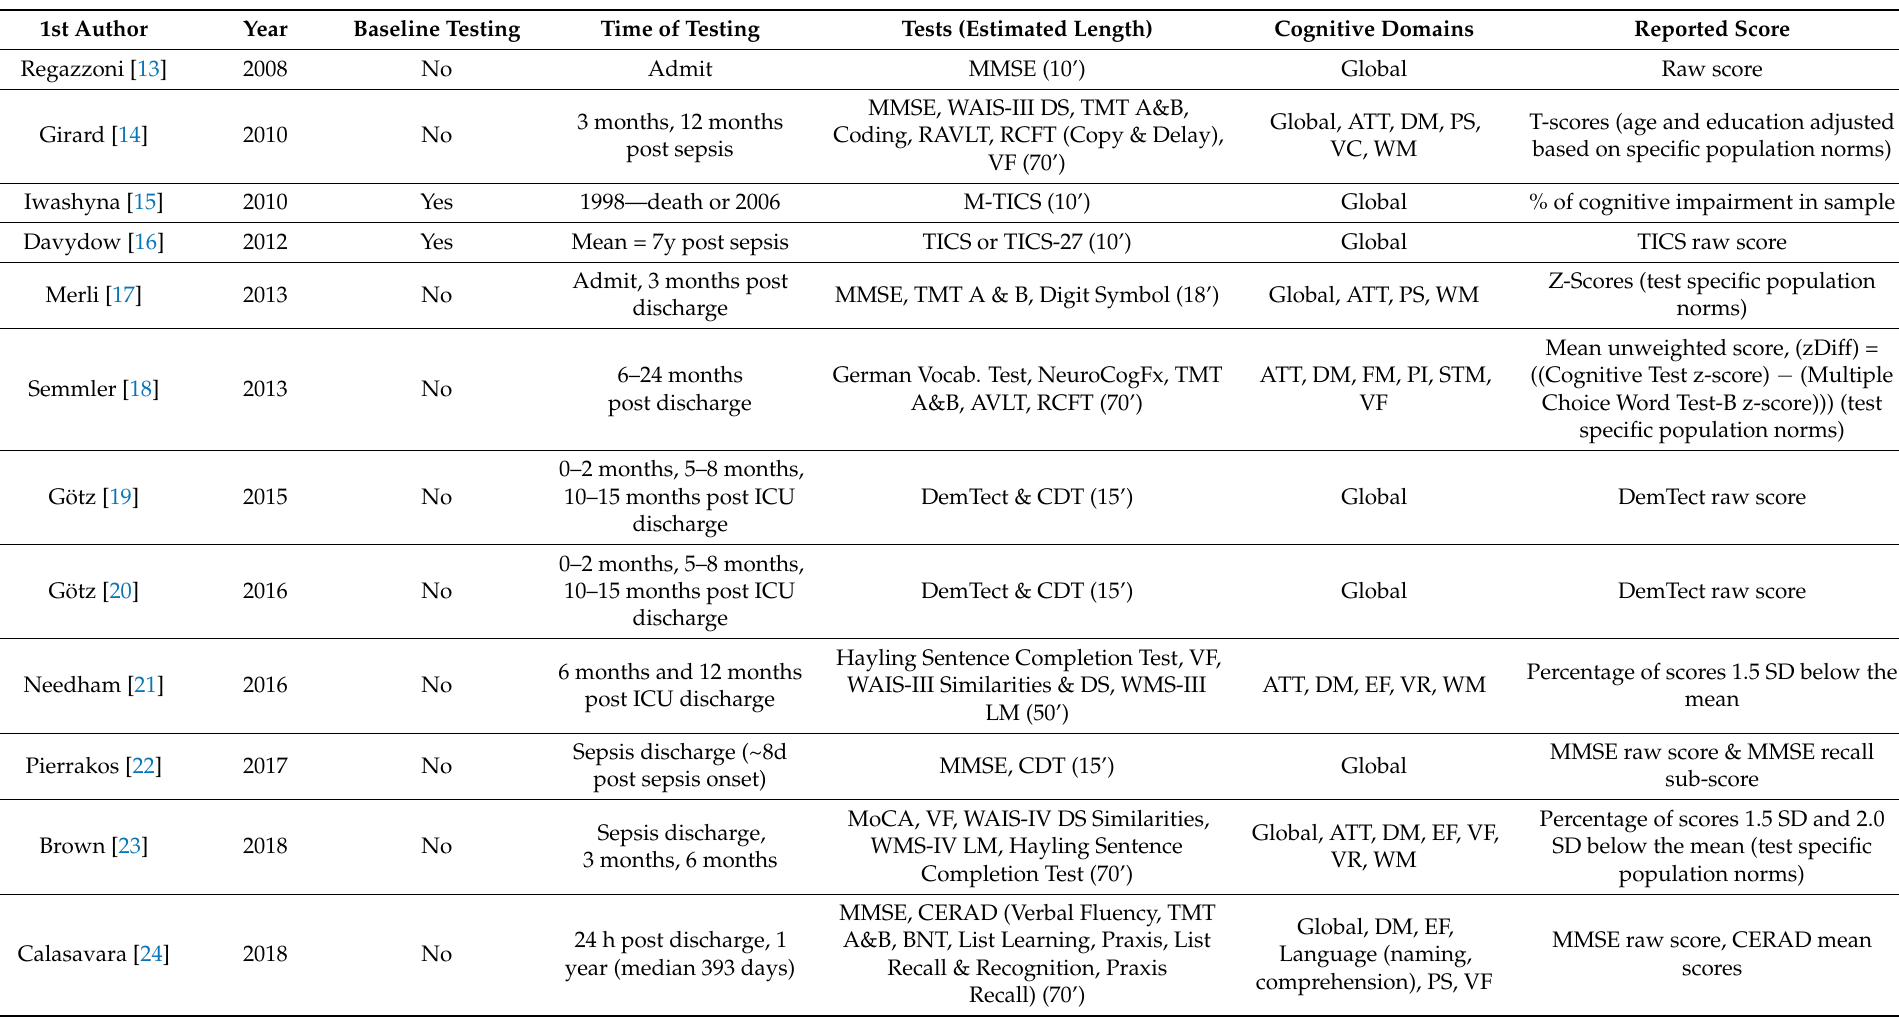
Table 2. Study designs and cognitive testing